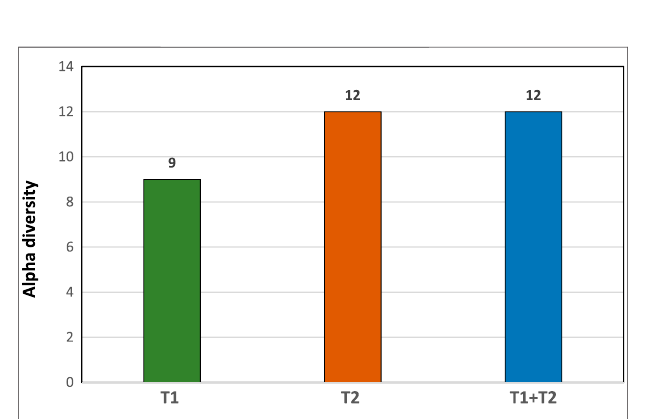
FIGURE 4 | Alpha diversity (species richness) from the two sections of Some ș ul Cald River.